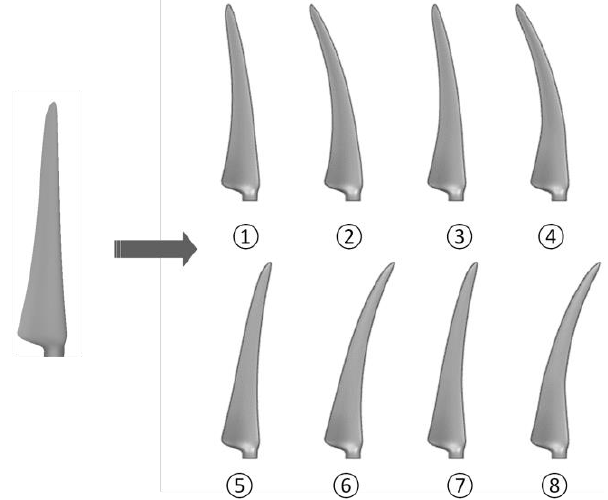
Figure 2. Sketches of the straight blade and designed swept blades.